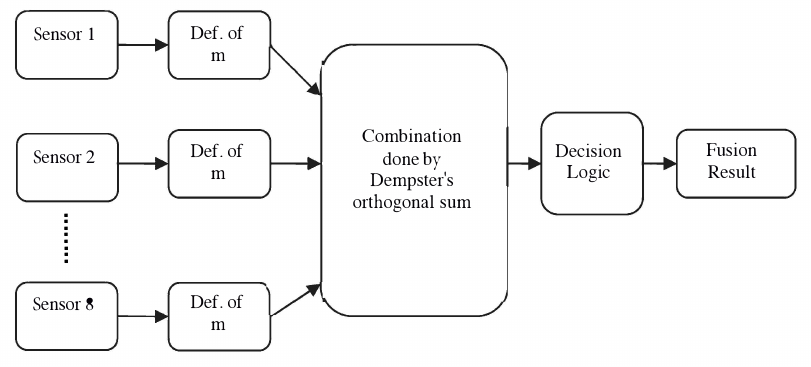
Figure 3. Fusion process with Dempster-Shafer’s